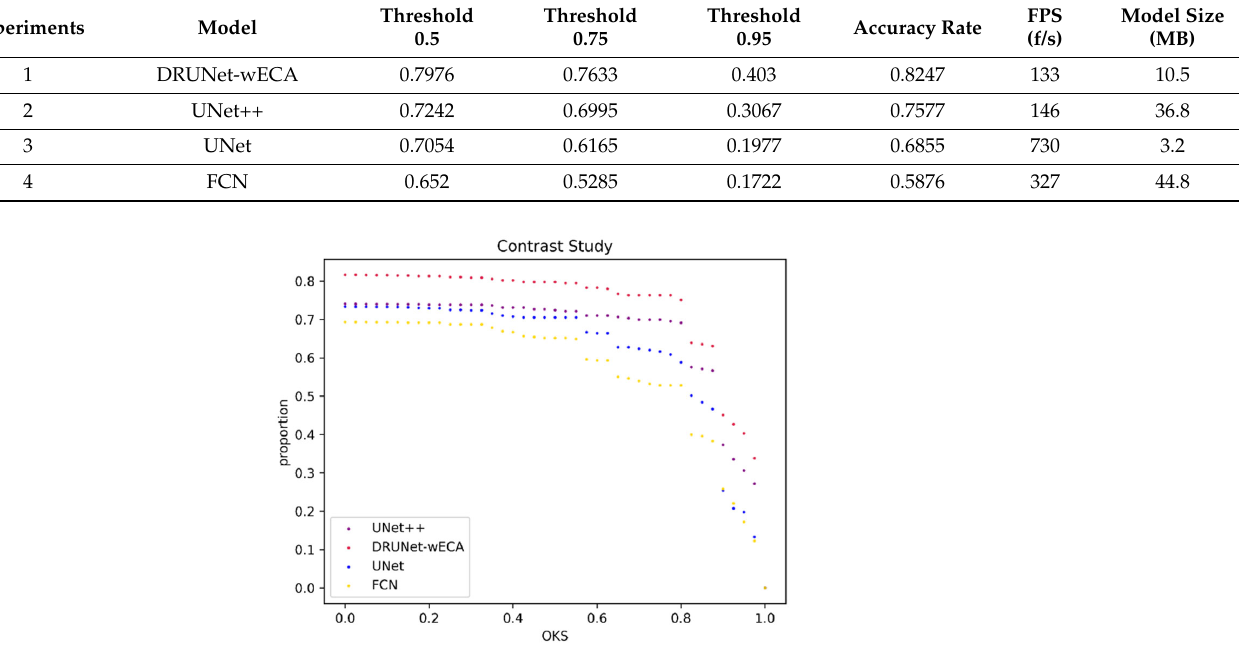
Figure 9. The figure shows the OKS scatter plot of the constant experiment, with the horizontal coordinate showing the different OKS thresholds and the vertical coordinate showing the proportion of test samples meeting the current OKS threshold to the total test samples. FPS indicates the number of images that our experimental platform can process per second, and model size indicates the size of the trained model weights. scatter plot, our proposed algorithm keeps leading in terms of the ratio at different thresh ‐ olds. Using FCN ‐ 32S as the backbone has the worst result, with a difference of 0.2371 from the accuracy rate of our proposed addition algorithm. This is because, in the up ‐ sampling part of FCN ‐ 32, it uses a transposed convolution with a step size of 32 to upsample the feature map 32 times, reducing it to the original map size. However, the disadvantage of the FCN ‐ 32S model is that the final feature map is upsampled 32 times at once during the up ‐ sampling process, at which time a lot of details are lost during the up ‐ sampling process because the feature map of the last layer is too small. Compared with FCN ‐ 32S, UNet